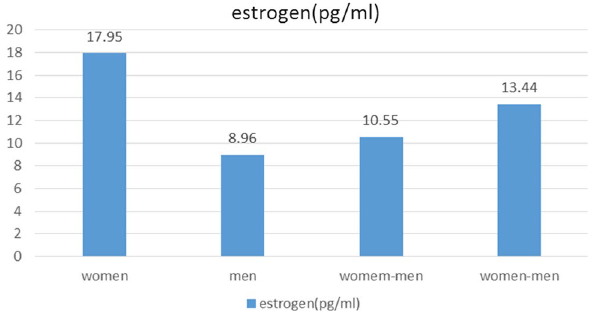
Fig. 3 Average changes of estrogen in the